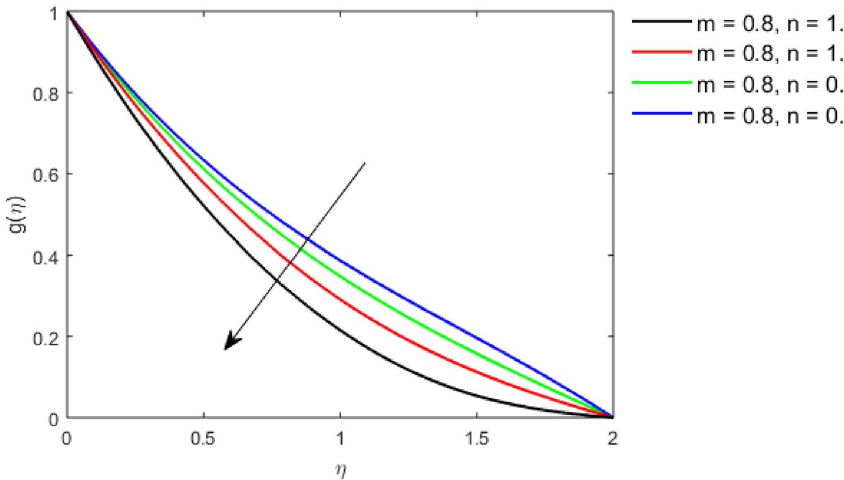
Figure 3. The Tangential velocity profile for decreasing power-law fluid index with thickness index m = 0.8, r = 0.6, Pr = 1 of a disk.